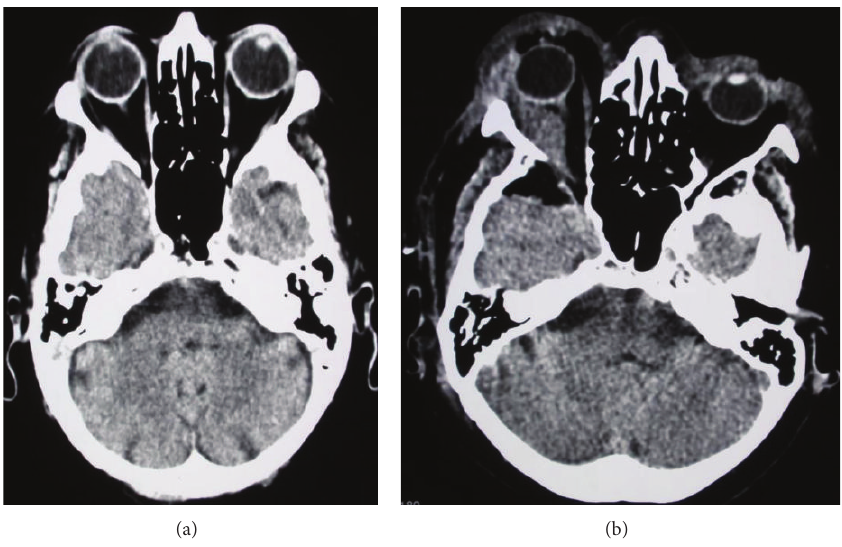
Figure 3: CT, pre- and postoperative: (a) Preoperative CT: intraorbital mass (thick arrow) and partially removed bone of the orbital roof (thin arrow) are seen. (b) Postoperative CT: the intraorbital mass has been removed and the exophthalmos is less clearly evident in comparison to preoperative images.